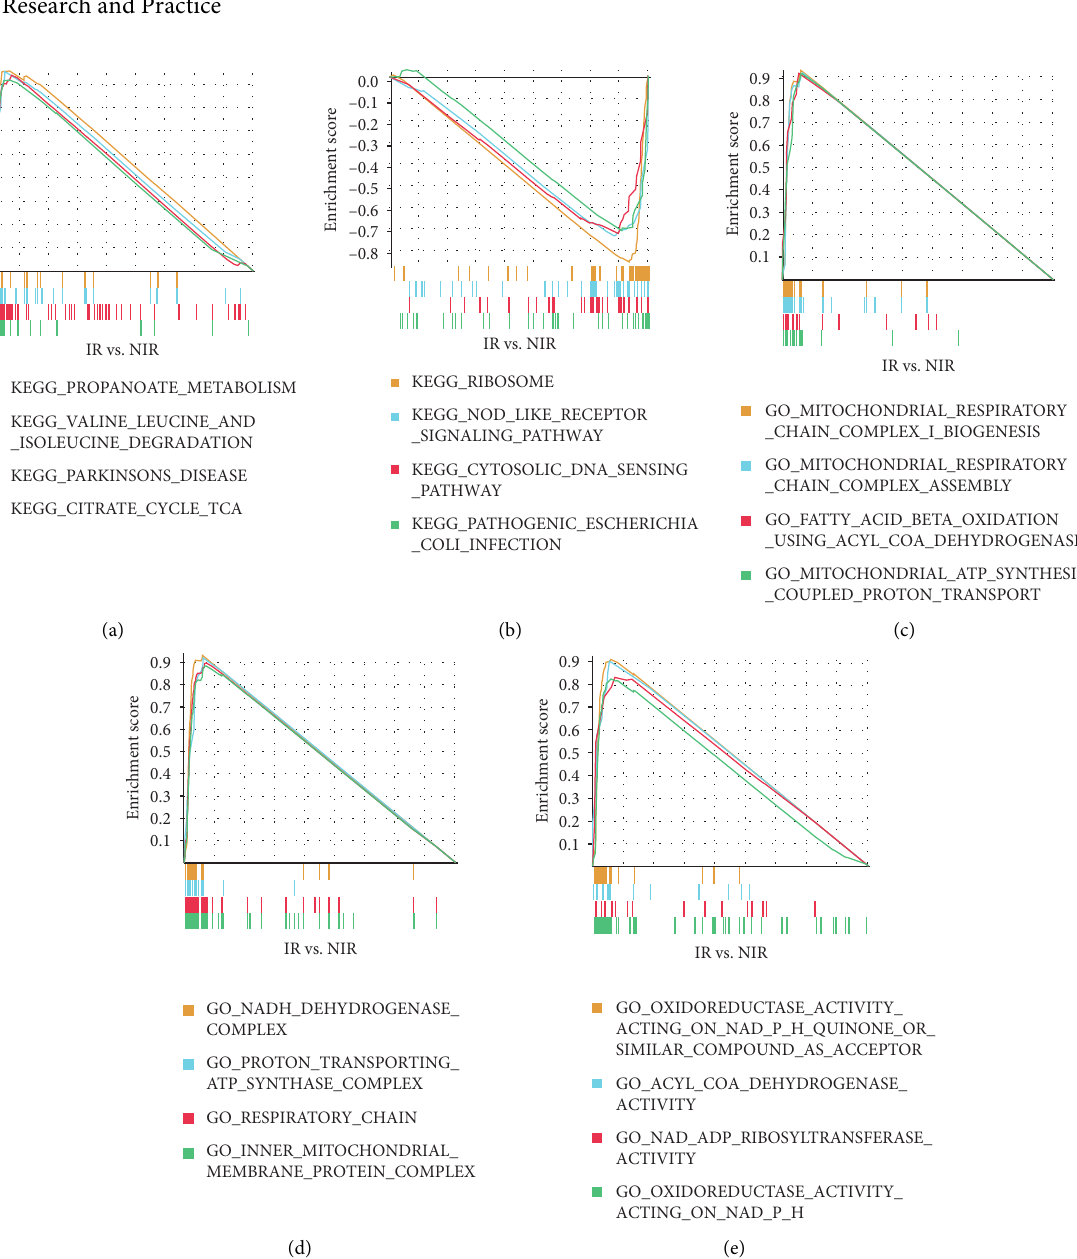
Figure 2: Enrichment analysis by GSEA. (a) In gene sets of KEGG, GSEA revealed that the genes of IR were mainly enriched in propanoate metabolism, valine, leucine, and isoleucine degradation, Parkinson’s disease, and citrate cycle (TCA cycle). (b) In gene sets of KEGG, GSEA revealed that the genes of IR were mainly negatively enriched in ribosome, NOD-like receptor signaling pathway, DNA sensing pathway, and pathogenic Escherichia coli infection. (c–e) In gene sets of GO, GSEA revealed that the genes of IR were mainly enriched in mi- tochondrial respiratory chain complex 1 biogenesis, mitochondrial respiratory chain complex assembly, fatty acid beta oxidation using acyl- CoA dehydrogenase, mitochondrial ATP synthesis coupled proton transport, NADH dehydrogenase complex, proton-transporting ATP synthase complex, respiratory chain, inner mitochondrial membrane protein complex, oxidoreductase activity acting on NADPH quinone or similar compound as the acceptor, acyl-CoA dehydrogenase activity, NAD-ADP ribosyl transferase activity, and oxidoreductase activity acting on NADPH. (a) GSEA (KEGG). (b) GSEA (KEGG). (c) GSEA (biological process). (d) GSEA (cellular component). (e) GSEA (molecular